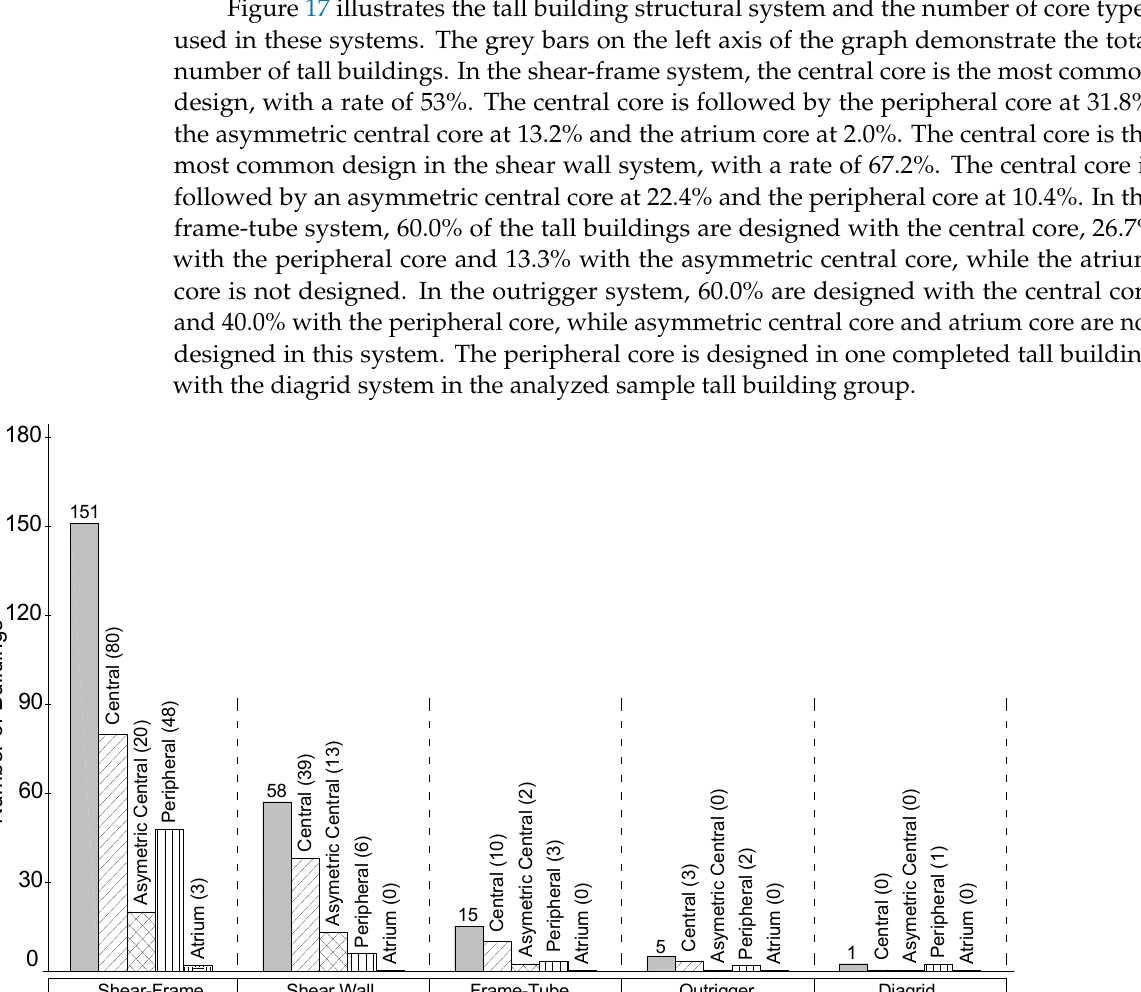
Figure 16. Relation between building function and building structural system.